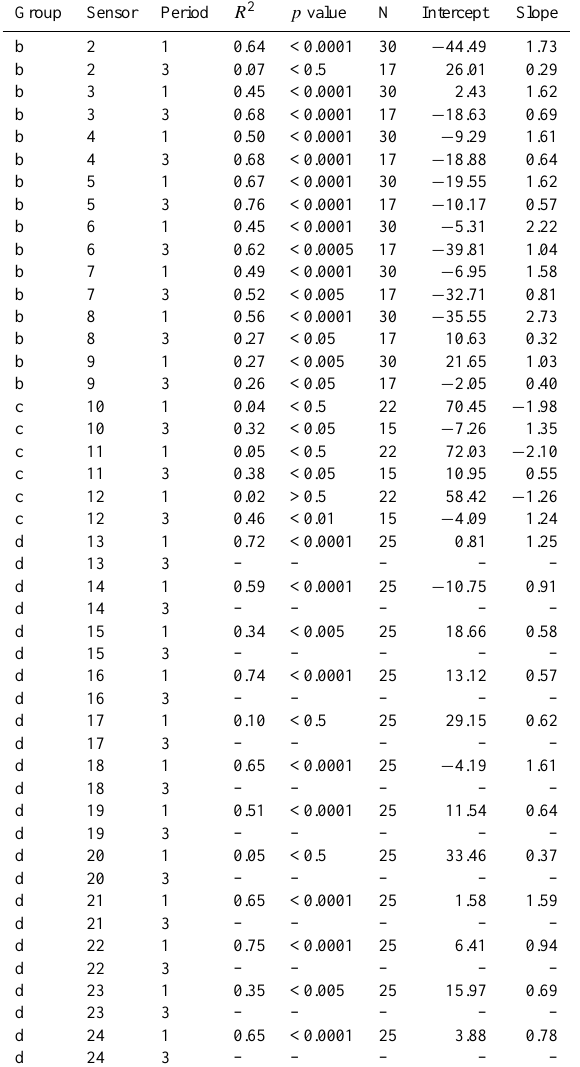
Table 2. Regression parameters for the linear relationships shown in Fig.